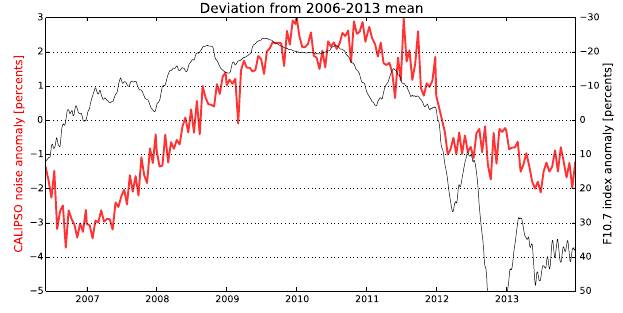
Fig. 2. Deviation of the fraction of noisy profiles (dark noise DC above 500) from the Figure 2. Deviation of the fraction of noisy profiles (dark noise 2006-2013 mean (48.9%) averaged over 15-days windows in the SAA region (red box in above 500) from the mean over the entire period (49.1%) in 15- Fig. 1). The black line shows the corresponding anomaly of F10.7 index, used as proxy of solar activity, delayed by one year. ! day periods between 2006 and 2012 in the SAA region (red box in Fig. 1), delayed by 1